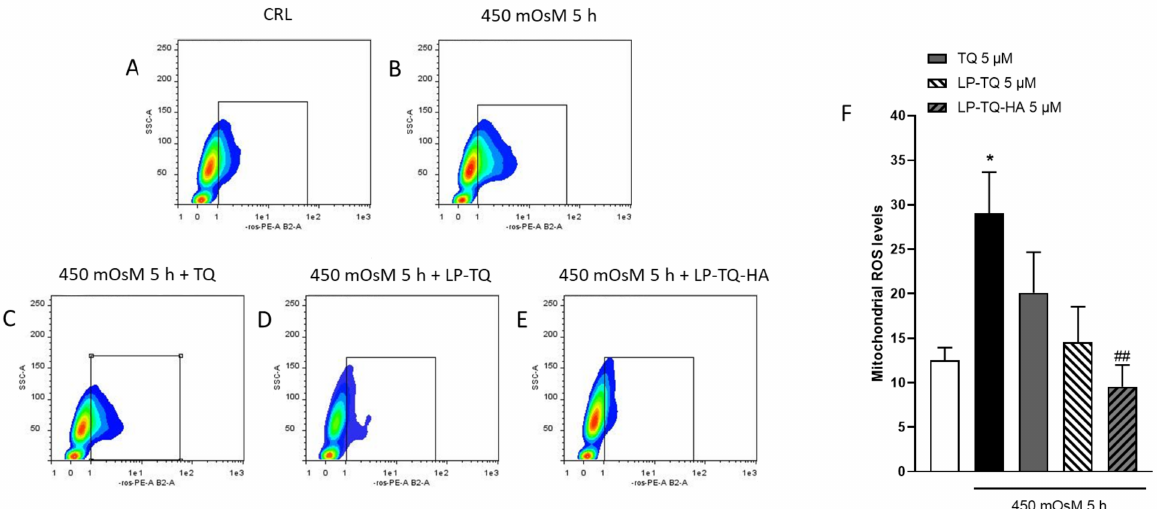
Figure 4. The effects of TQ on mtROS production in HCE-2 cells exposed to hyperosmotic media. Cells were exposed to 450 mOsM for 5 h and then processed for the quantification of mtROS by cytofluorimetric analysis. Free- and formulated TQ were present in the incubation medium during hyperosmolarity exposure. ( A – E ) representative plots showing the amount of ROS produced during the treatments. The red color represents the highest density within a population. With decreasing density, the color transitions from yellow over green to blue. ( F ) quantitative analysis of plots, showing that only LP-TQ-HA can reduce significantly the increase levels of mtROS induced by 450 mOsM for 5 h. Dot show the results of six experiments. * p < 0.05 vs. CRL; ## p < 0.01 vs. hyperosmolarity. (ANOVA + Tukey’s